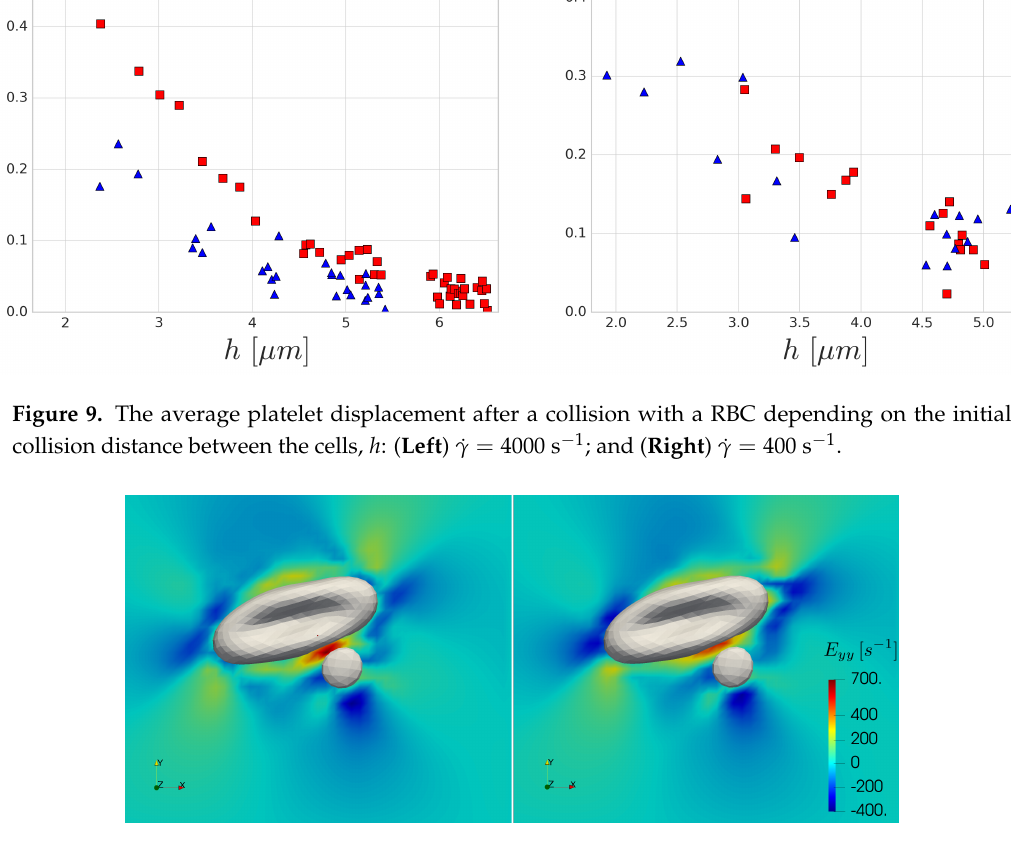
Figure 10. E yy component of the rate of strain tensor just before a collision event in bulk shear rate of 1000 s − 1 : ( Left ) with viscosity contrast; and ( Right ) without viscosity contrast. Note that the elongational strain is higher in the case of added viscosity